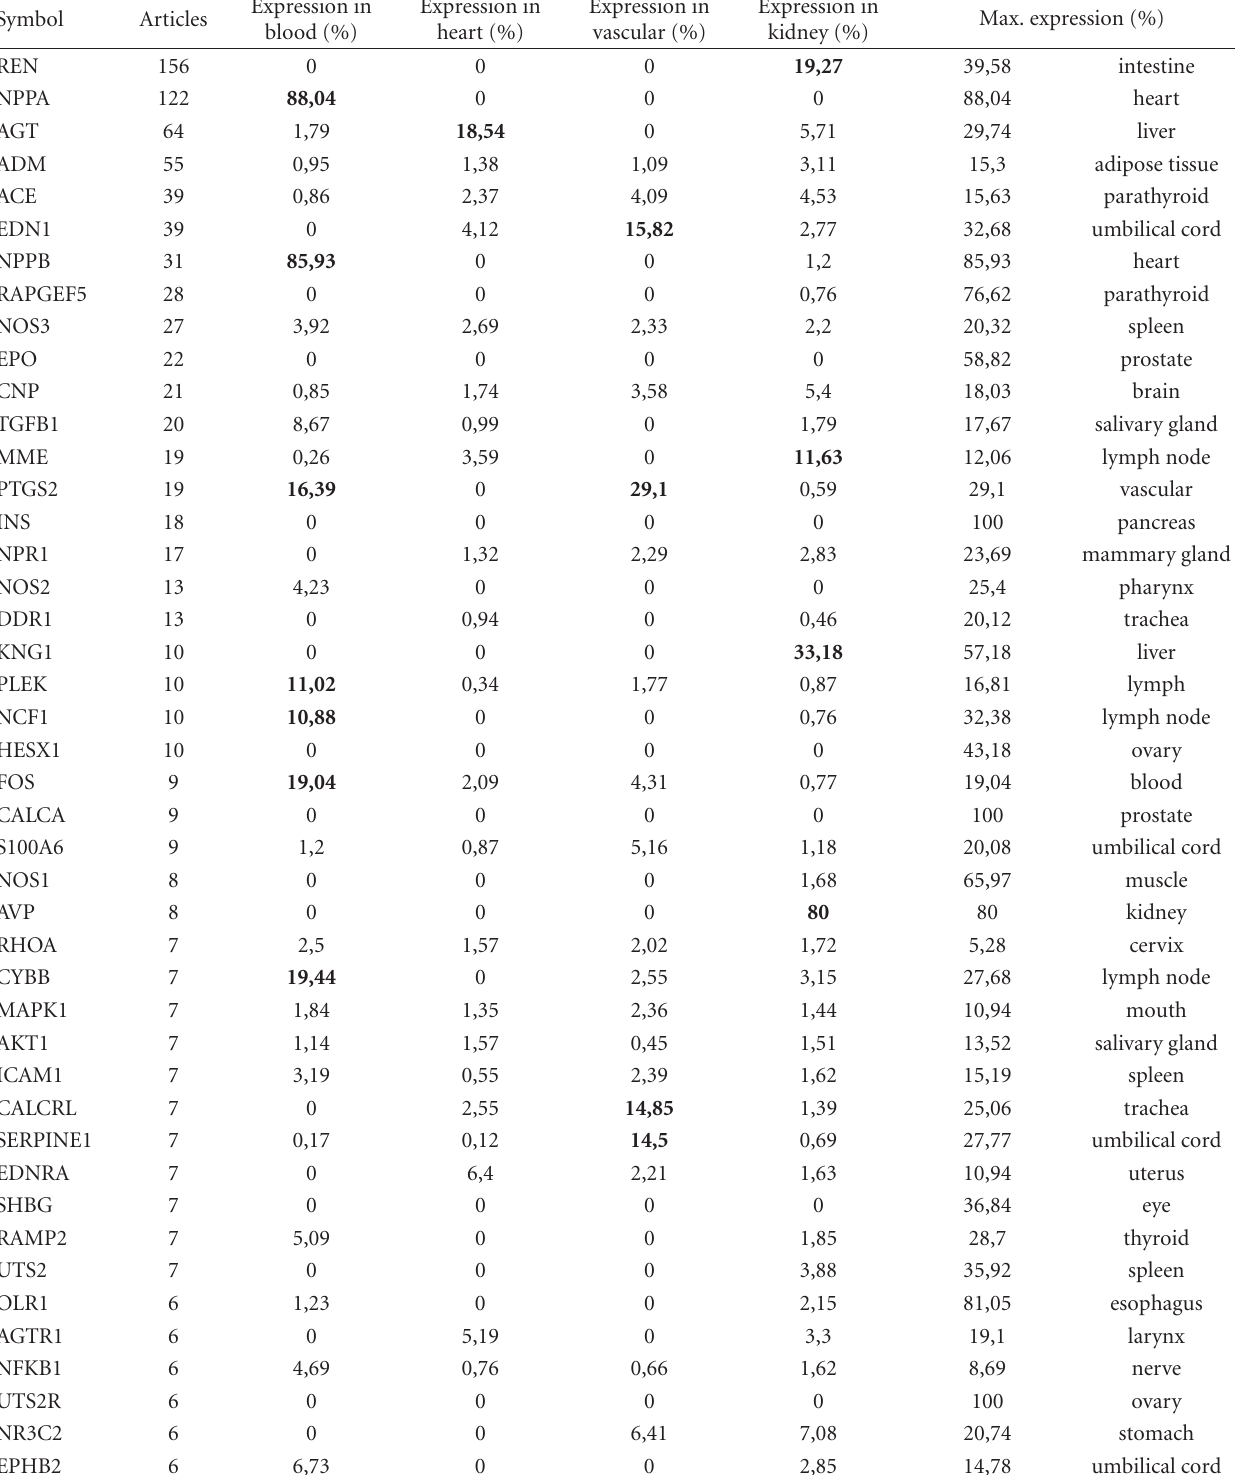
Table 1: List of identified genes/proteins, number of articles identified for cardiorenal, and relative expression levels based on UniGene EST counts for blood, heart, vascular, and kidney, and tissue showing maximum expression of a specific